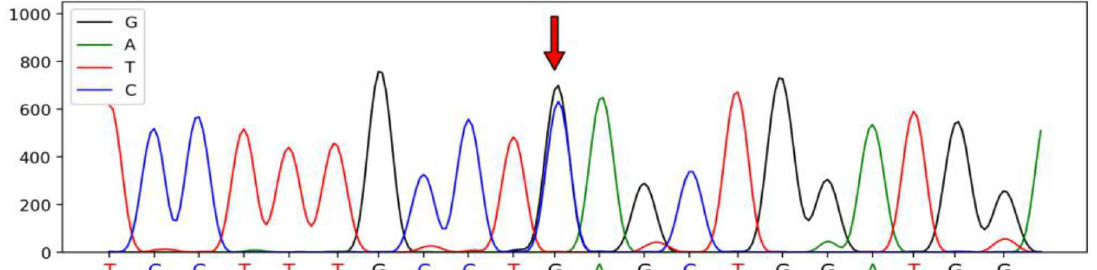
Figure 4. The sequencing peak map of the SSTR1 and the mutated SNP4 site of Hulun Buir sheep. The sites marked by the red arrow was the SNP4 mutation, which was found and identified in exon 2 of SSTR1 , G951C (rs405457403). The sequences were analyzed using DNAMAN software.